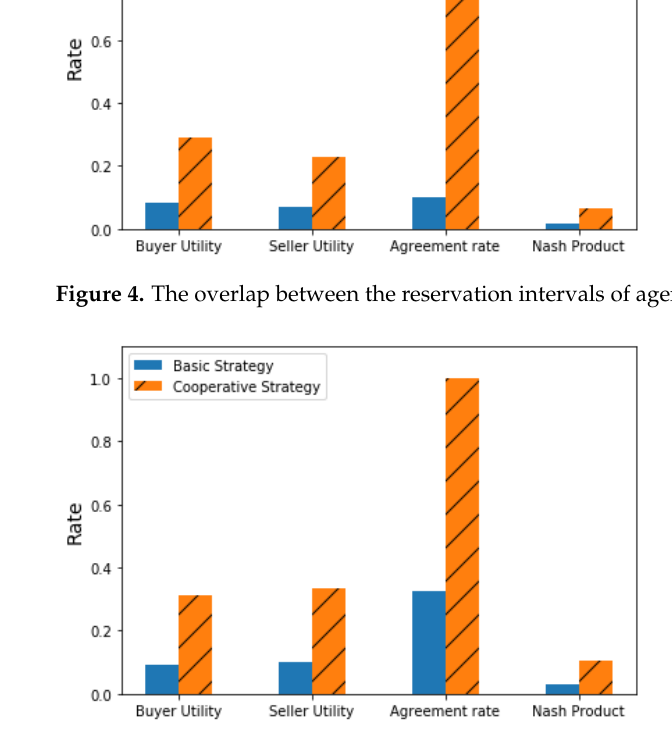
Figure 5. The overlap between the reservation intervals of agents is medium.